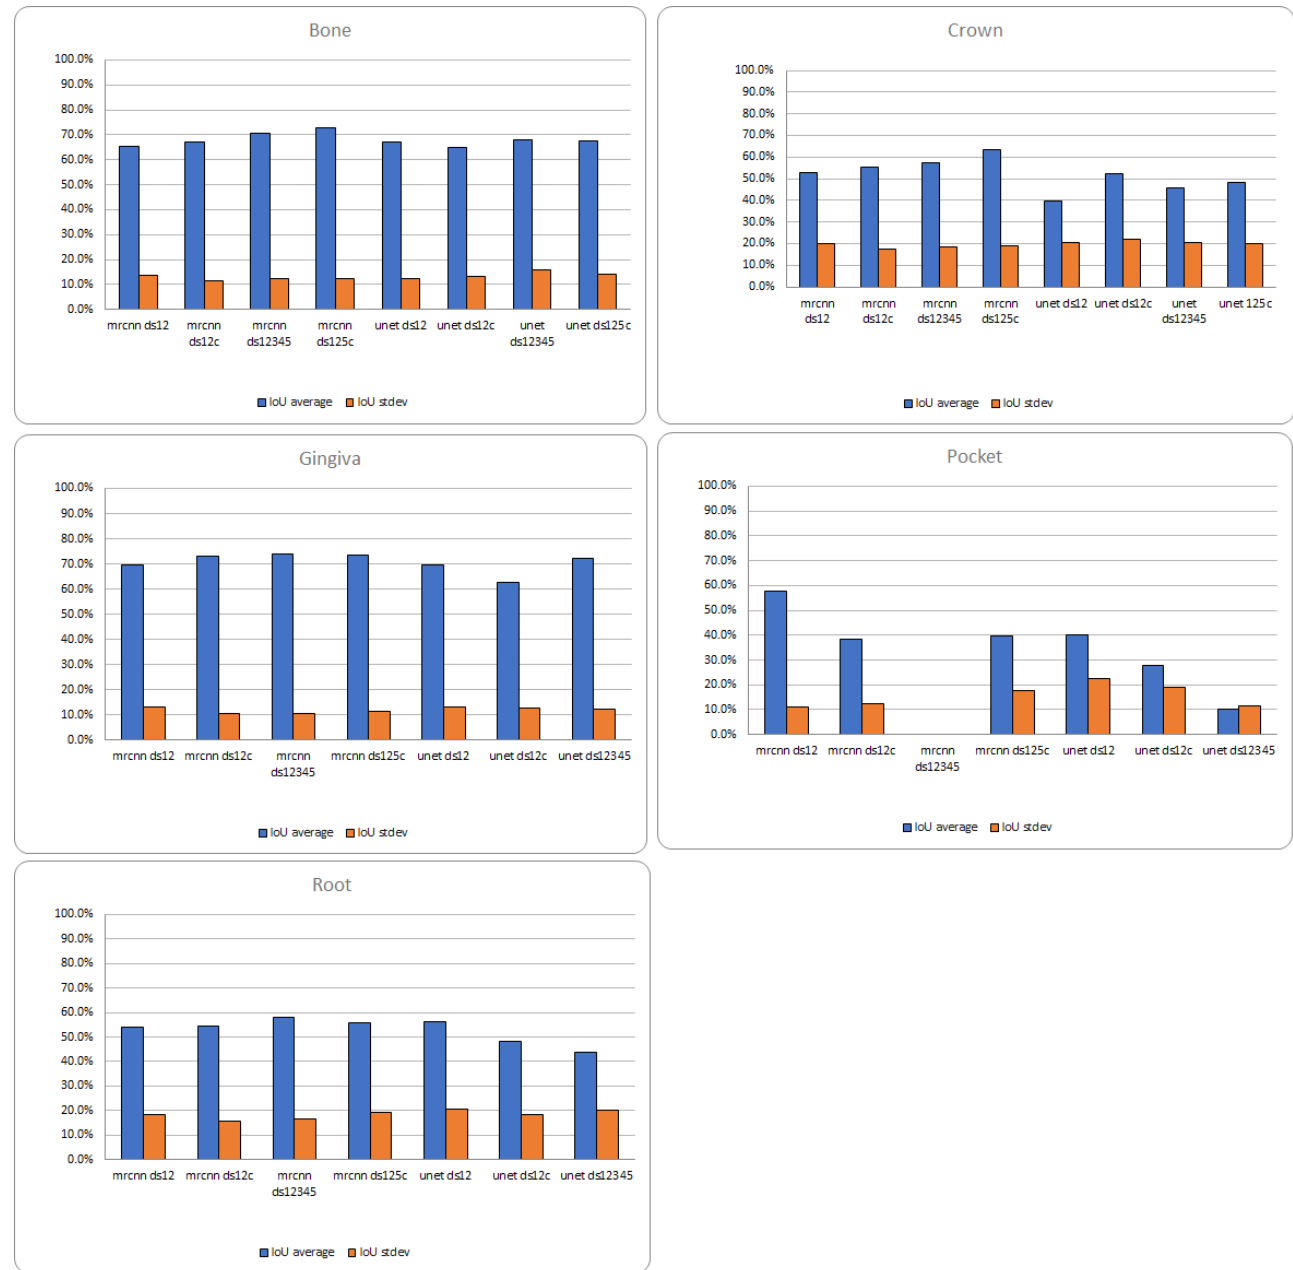
Figure 15. Mask R CNN and U-NET trained with different datasets: accuracy prediction evaluation using IoU average and standard deviation.